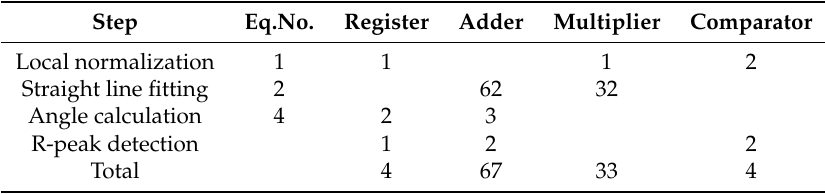
Table 3. Computational resource cost of each step in Hu’s algorithm